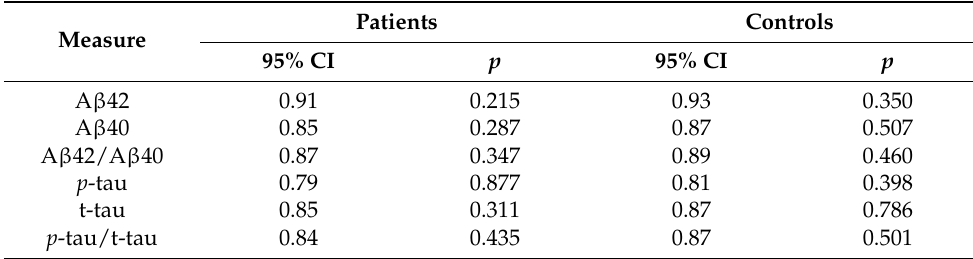
Table 2. Saliva biomarkers in